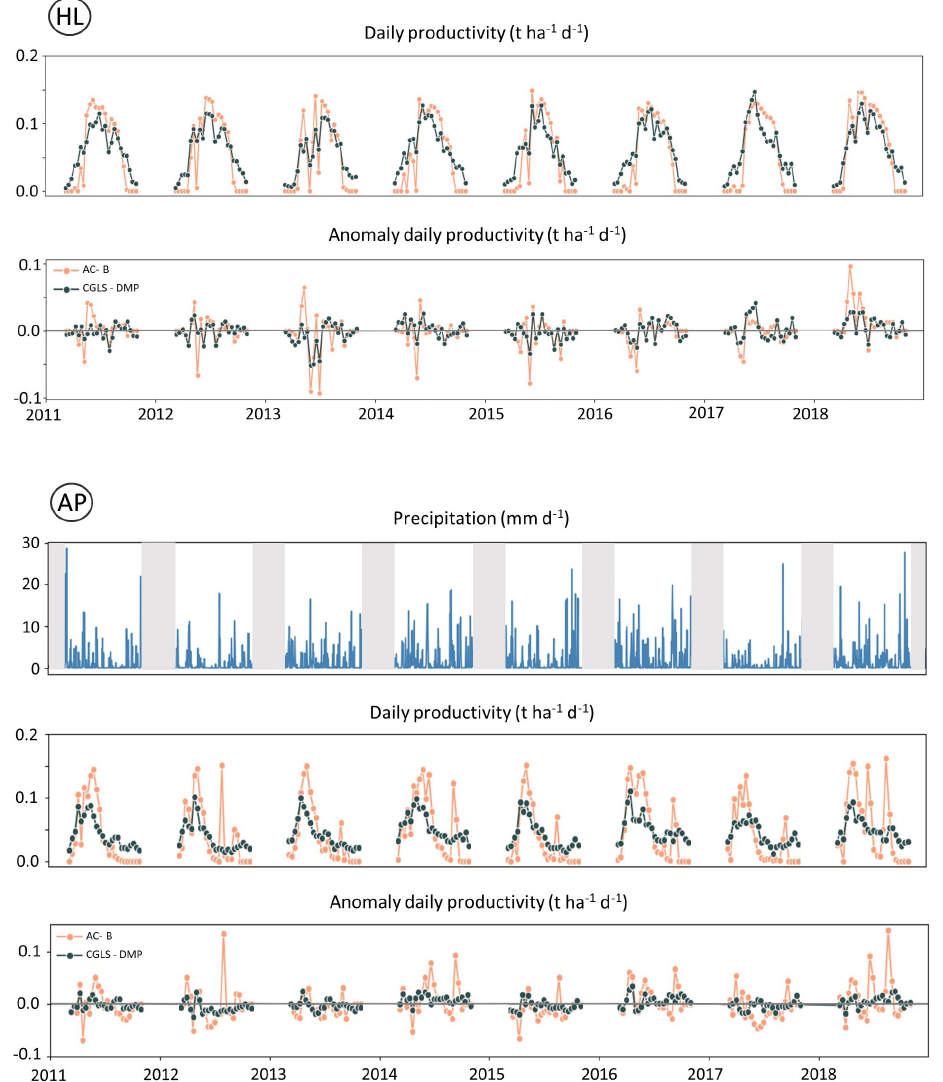
Figure 5. Time series of biomass productivity, anomaly daily productivity (and precipitation) for (HL) the HOAL catchment in Austria, and (AP) a pixel in the Apulia region of southern Italy; both are marked in Fig. 3. Precipitation is only shown for AP because it has a marked effect there on short-term anomaly productivity. Periods between October and March are masked out in grey for